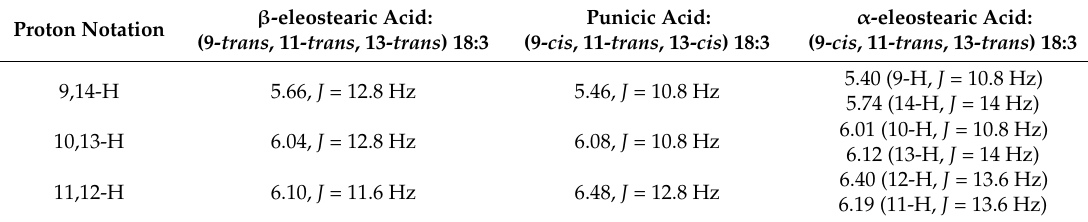
Table 5. 1 H-NMR chemical shift values (ppm) and coupling constants (Hz) of olefinic hydrogens of conjugated linolenic acids (CL n As) in CDCl 3 . Reprinted, with permission, from [58]. Copyright 2006, American Chemical